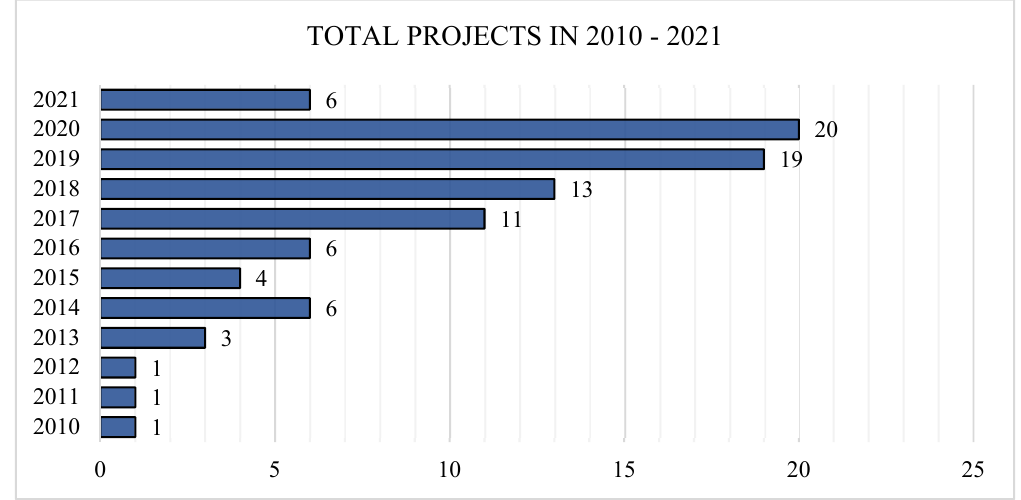
Figure 2. Number of the research time distribution of projects from 2010–2021.